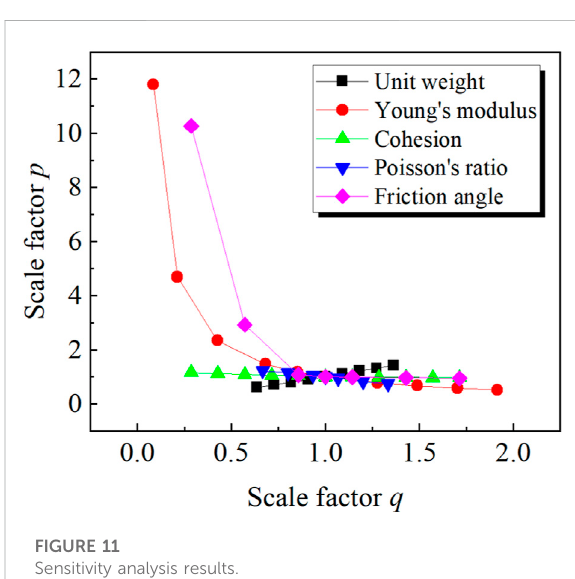
FIGURE 11 Sensitivity analysis results.